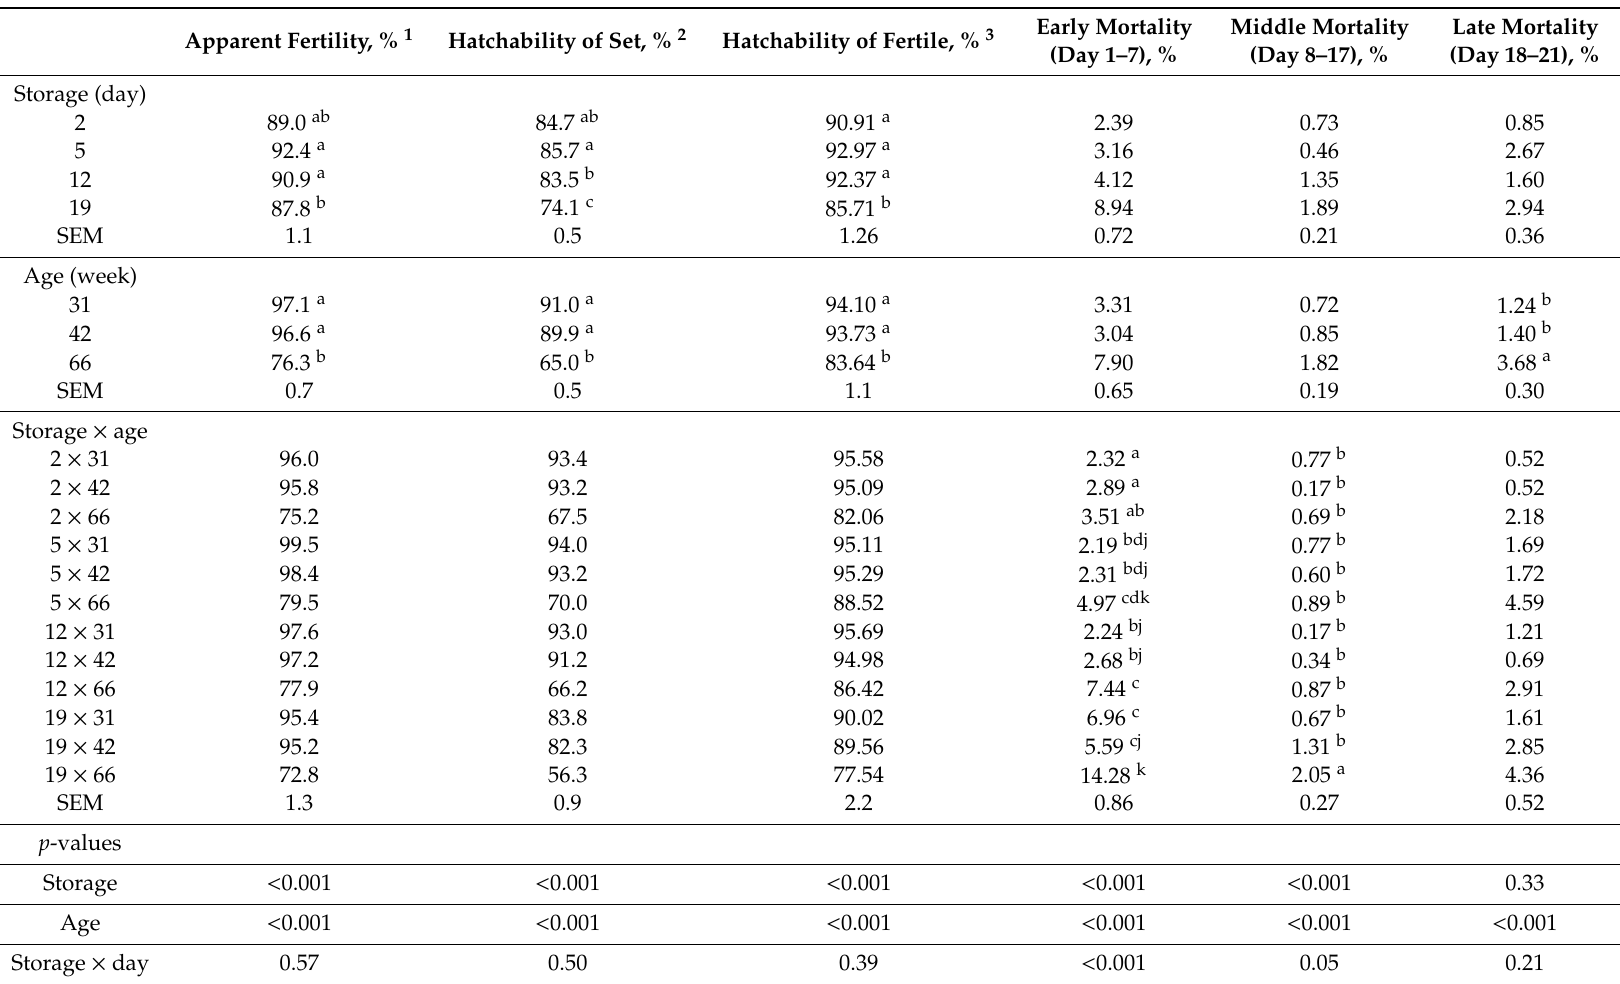
Table 3. E ff ects of egg storage duration, broiler breeder age and their interaction on apparent fertility, hatchability and embryonic mortality (means ± SE). Apparent Fertility, % 1 Hatchability of Set, % 2 Hatchability of Fertile, % 3